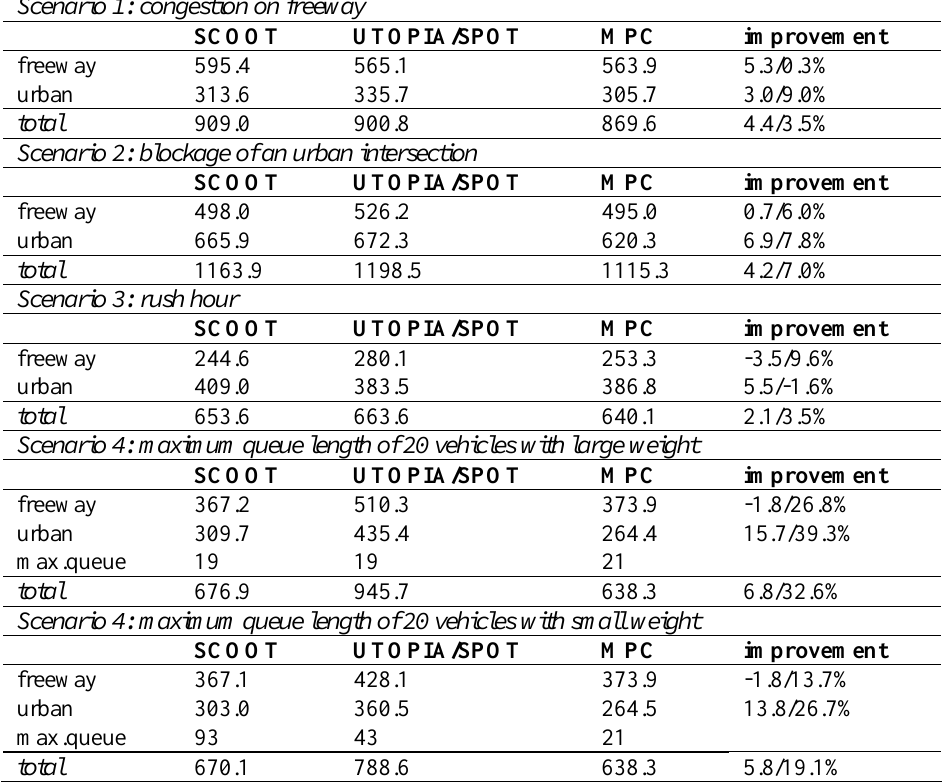
Table 1. Results of the case study: total time spent for the freeway part of the network, for the urban part, and for the total network; and also the improvement of the MPC- based method compared to SCOOT and UTOPIA/SPOT respectively Scenario 1: congestion on